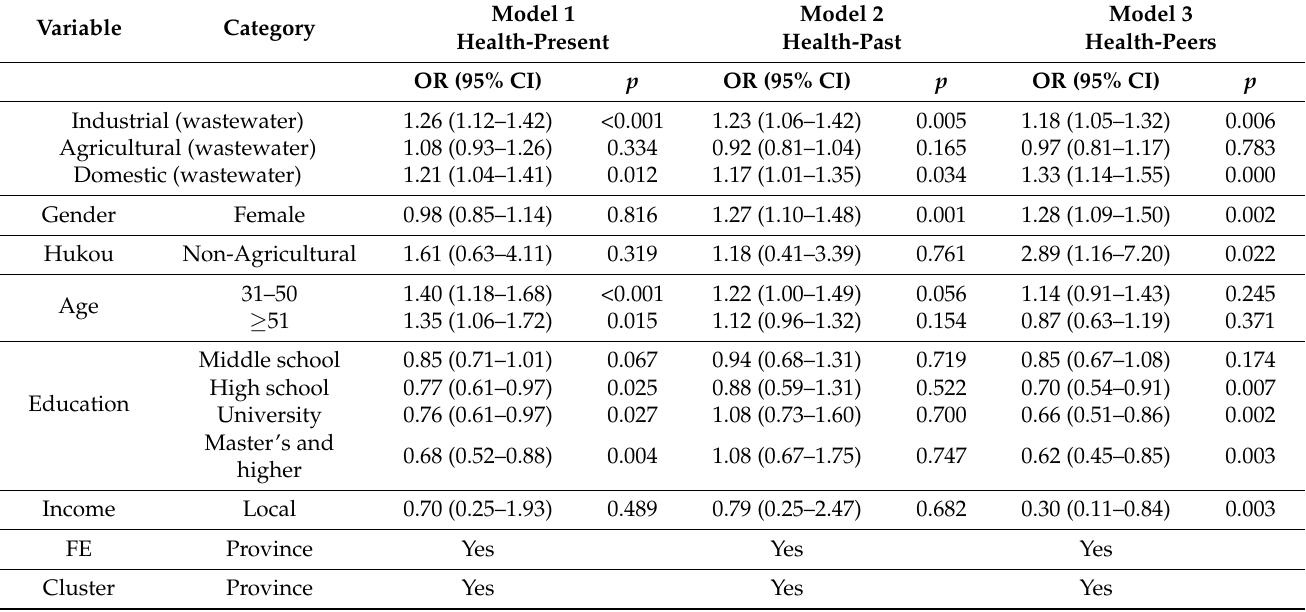
Table 3. The influence factors of Chinese individuals’ self-rated